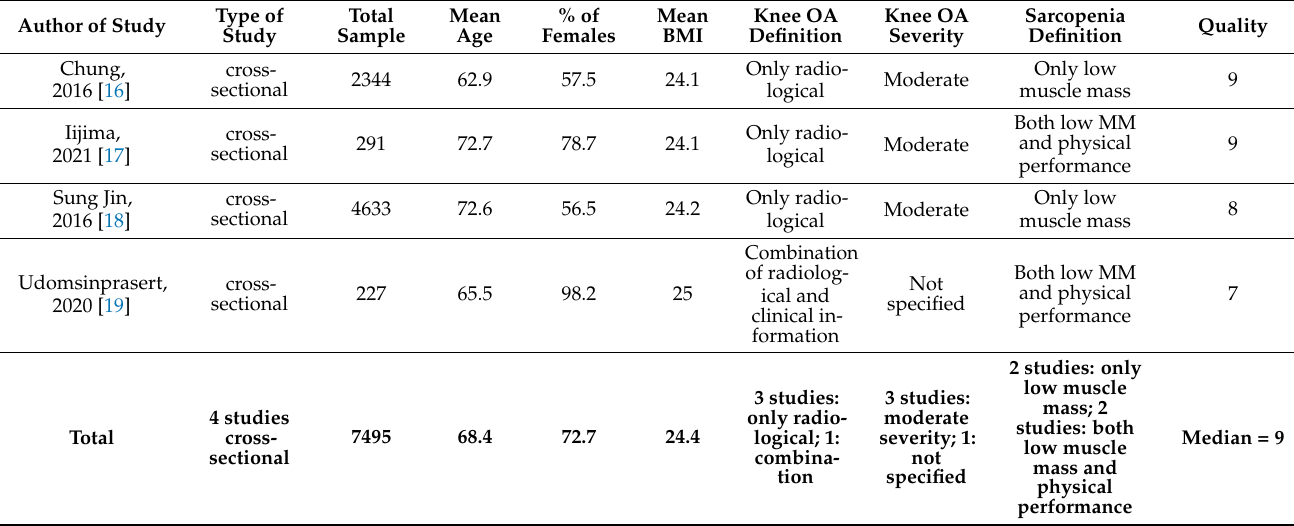
Table 1. Descriptive characteristics of the studies included.